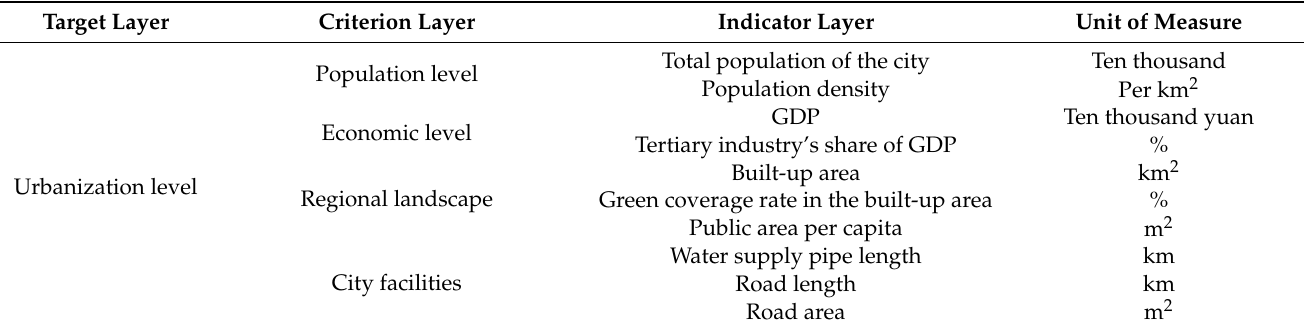
Table 1. Evaluation index system for measuring urbanization